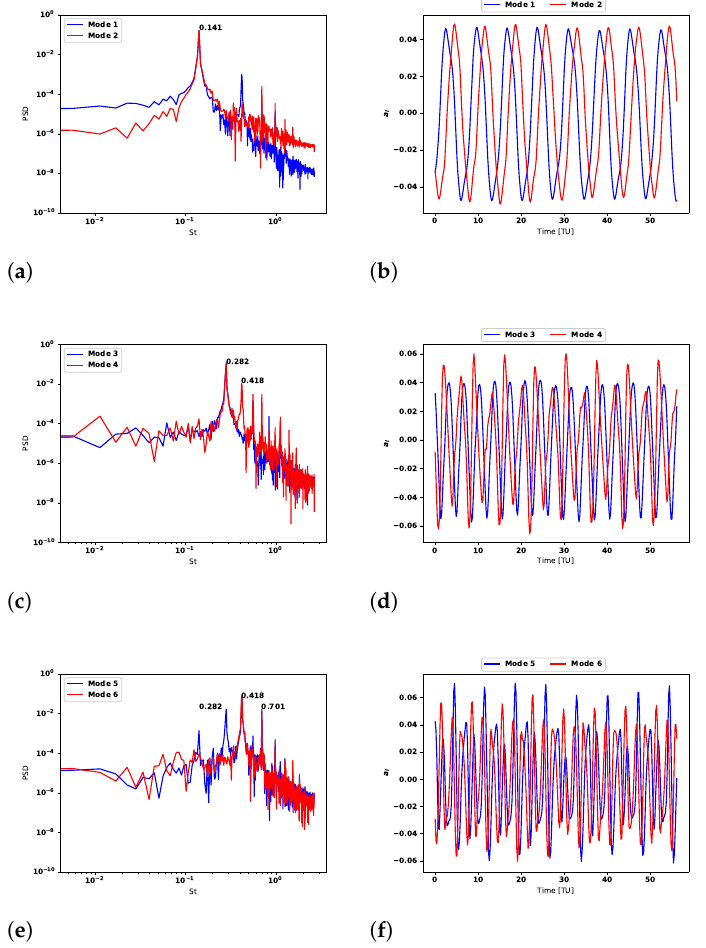
Figure 13. Energy spectra ( a , c , e ) and the first 60 TU of the time coefficients ( b , d , f ) of each of the three pairs of modes: 1–2, 3–4, and 5–6, respectively.